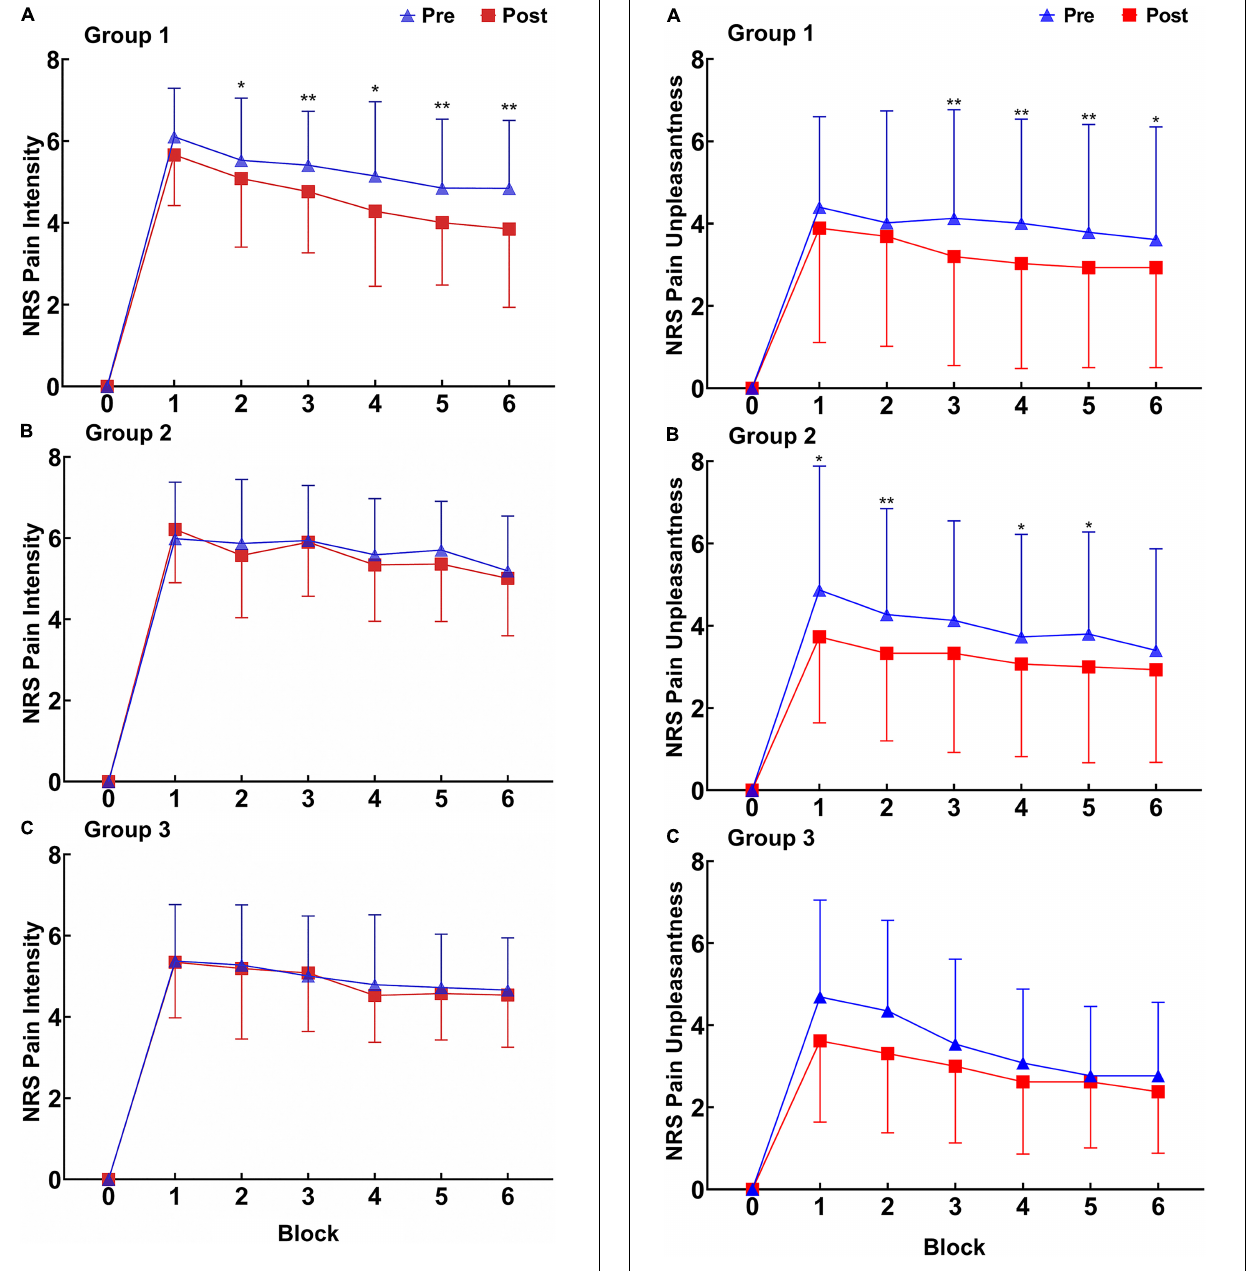
exercise heart rate ( r = 0.372, p = 0.020; r = 0.374, p =